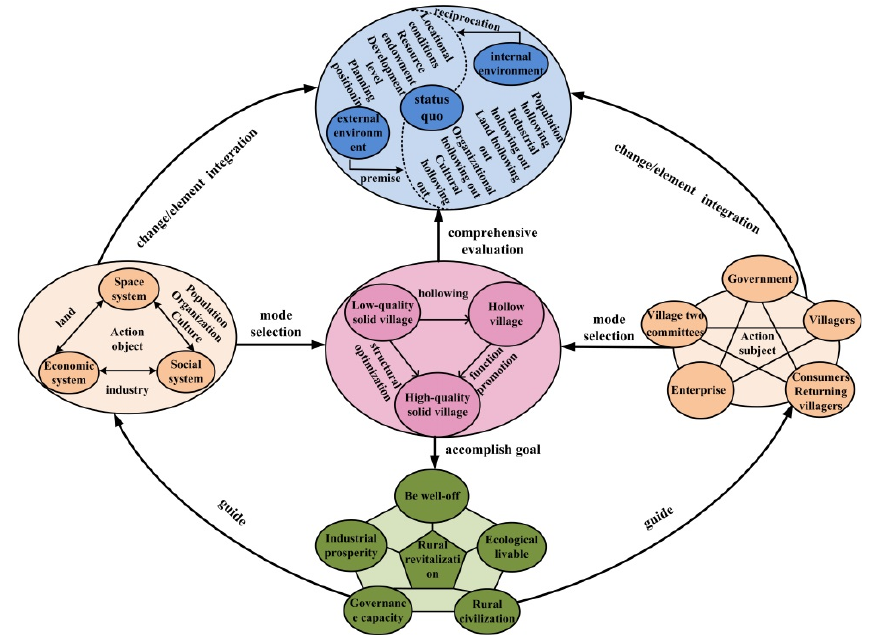
Figure 10. Governance mechanism of a hollow village based on action network.